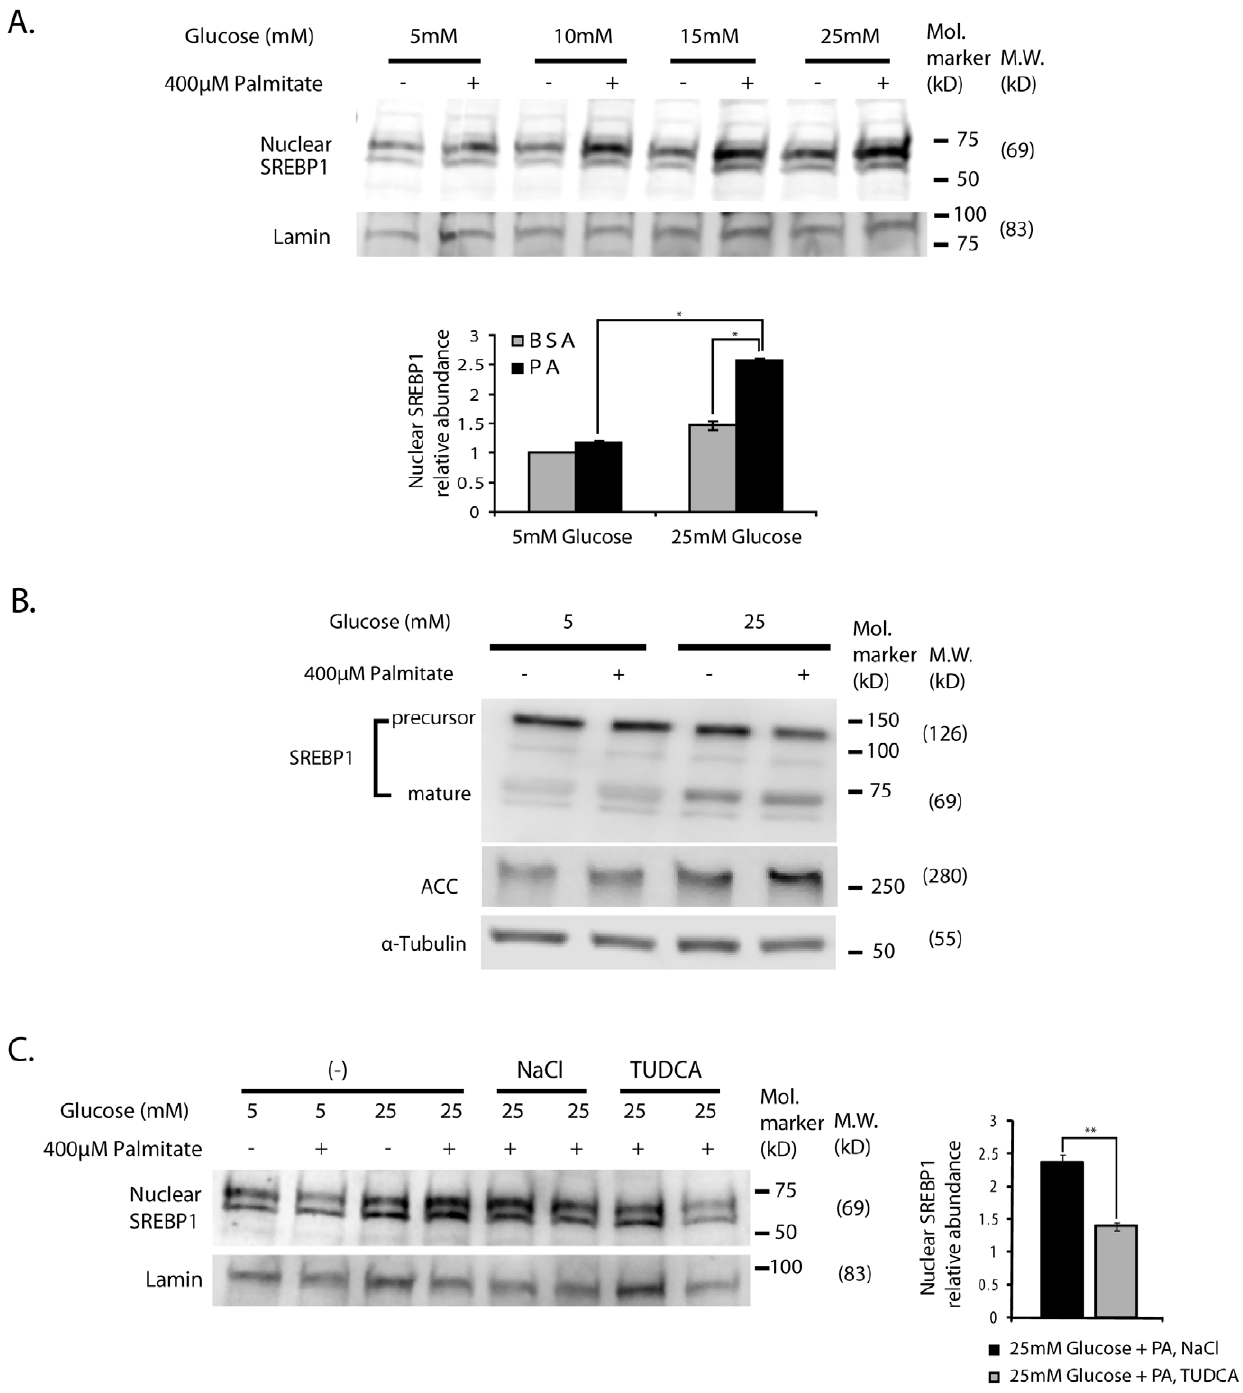
Figure 4. The synergistic effects of glucose and palmitate on ER stress results in concomitant effects on activation of SREBP1. ( A ) MIN6 cells were treated with either control 0.5% BSA or 400 m M palmitate + 0.5% BSA at a concentration of 5, 10, 15, 25 mM glucose for 18-h. Nuclear fractions were extracted from the cells and were subjected to Western blot analyses using anti-SREBP1 and anti-Lamin antibodies. 25 m g of nuclear protein was loaded in each lane. The upper band normalized over Lamin was used to do the quantification (the lower band is nonspecific). The relative ratio of nuclear SREBP1 over Lamin calculated by densitometries was summarized as means 6 S.E.M. in the graph respectively. The representative results of three experiments are shown, and graphically illustrated, * p , 0.05. ( B ) MIN6 cells were treated with either control 0.5% BSA or 400 m M palmitate + 0.5% BSA at a concentration of either 5 or 25 mM glucose for 24-h. Total cell lysates were subjected to Western blot analysis using anti-acetyl CoA carboxylase (ACC) and anti- a -Tubulin antibodies. The representative results of two individual experiments are shown. ( C ) Cells were treated with either 500 m g/ml NaCl or 500 m g/ml TUDCA 15-h prior to beginning of palmitate treatment. Cells were co-treated with either 0.5% BSA or 400 m M palmitate + 0.5% BSA with 25 mM glucose and NaCl or TUDCA for 18-h. Nuclear fractions were extracted from the cells and were subjected to Western blot analyses using anti-SREBP1 and anti-Lamin antibodies. The upper band normalized over Lamin was used to do the quantification (the lower band is nonspecific). 25 m g of nuclear extracts were loaded in each lane. The representative results of three individual